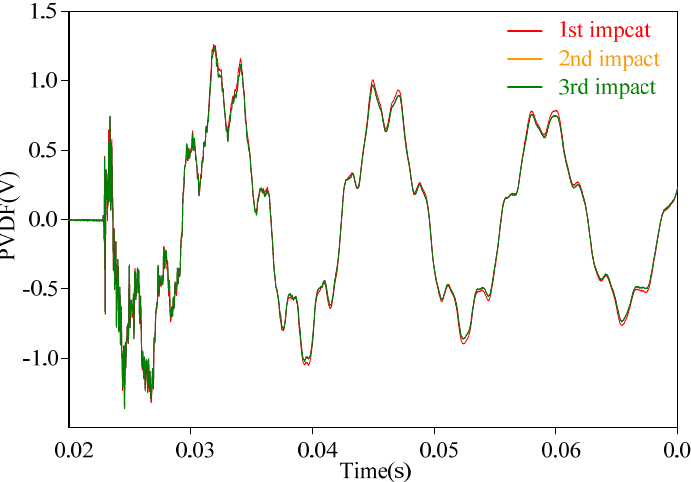
Figure 10. Experiment reproducibility with impact on location A.